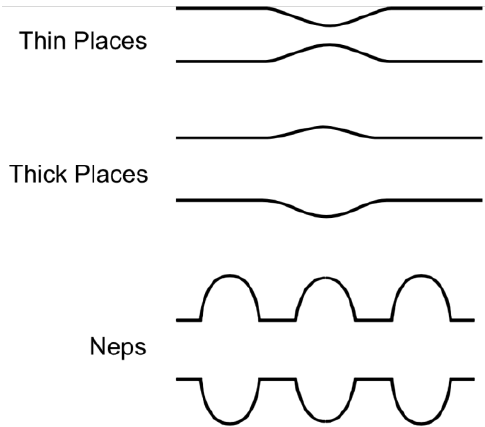
Figure 14. Types of dimensional imperfections (Adapted from [19]).